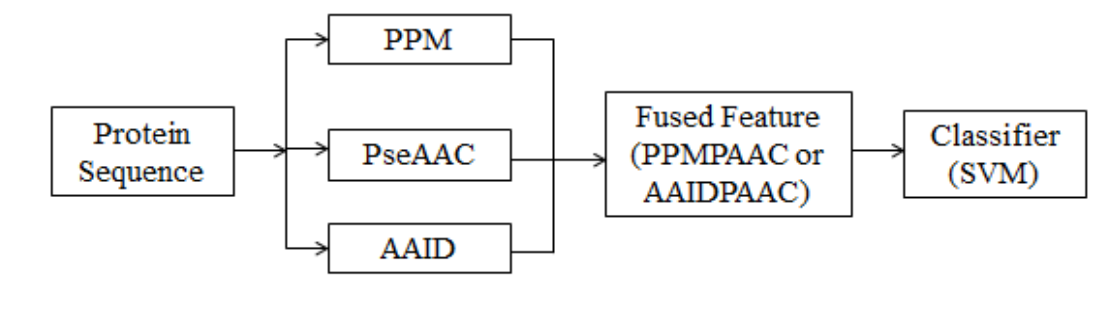
Figure 2: Flowchart of the prediction